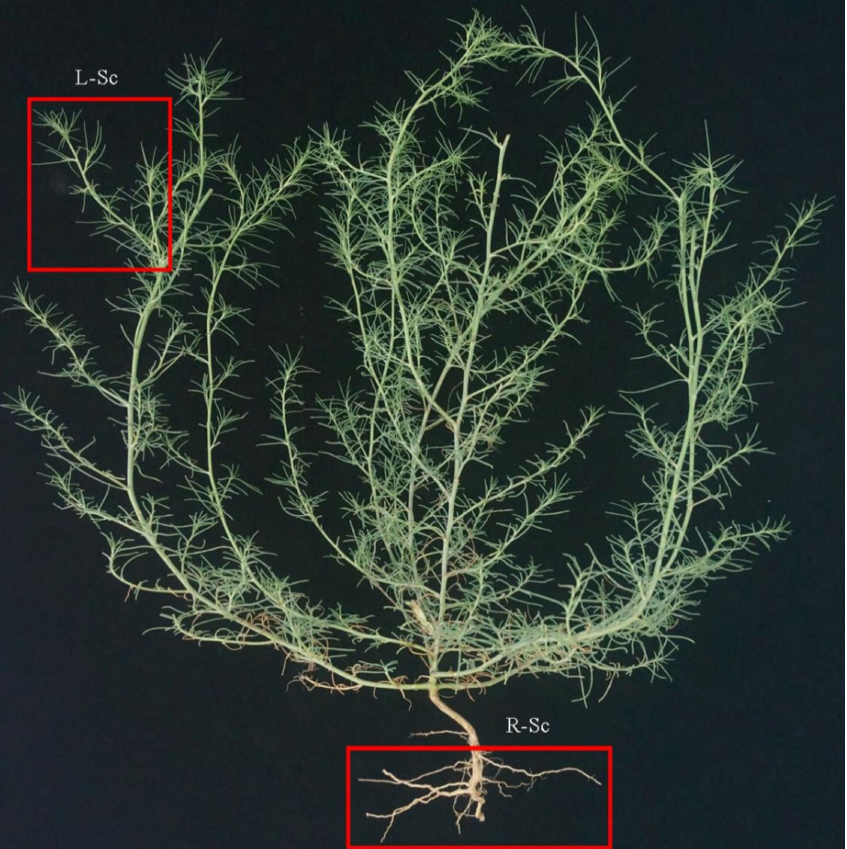
Figure 1. Phenotypes of S. collina